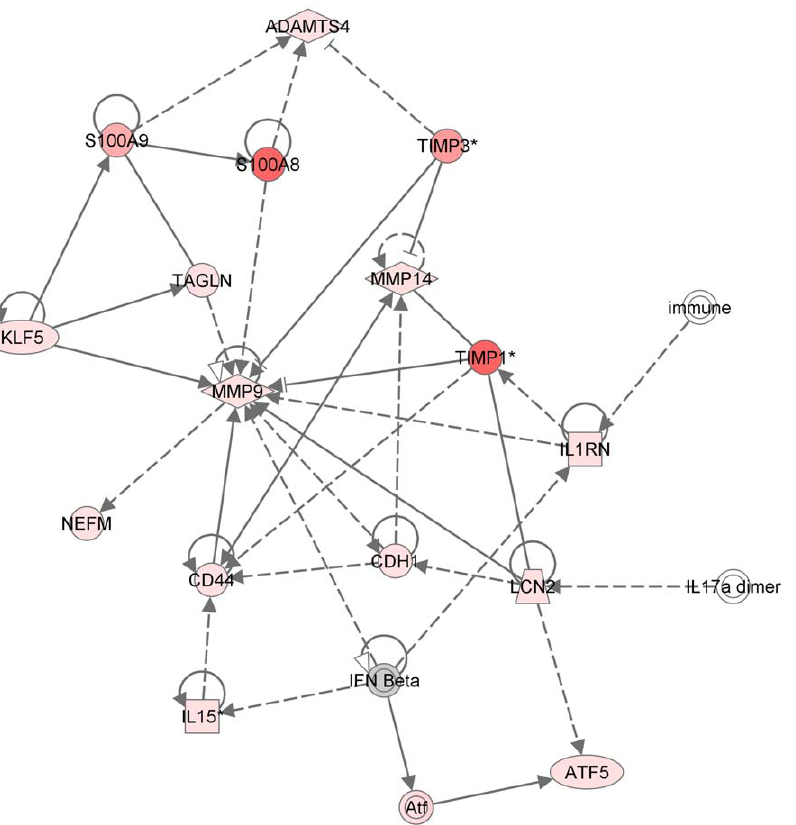
Figure 3. Pathway analysis based on the genome-wide transcriptional profiling suggests the presence of a functional link among MMP-9 TIMP-1, NGAL and CD44. Green and red indicate down- and up-regulated genes in the injured nerve at day 1 post-transection. Color intensity is directly proportional to the gene expression changes relative to sham-operated nerve. Ingenuity core pathway analysis was performed with expression values cutoff set at 300. The shape of the protein symbol shows cytokines, peptidases, transmembrane receptors, kinases and